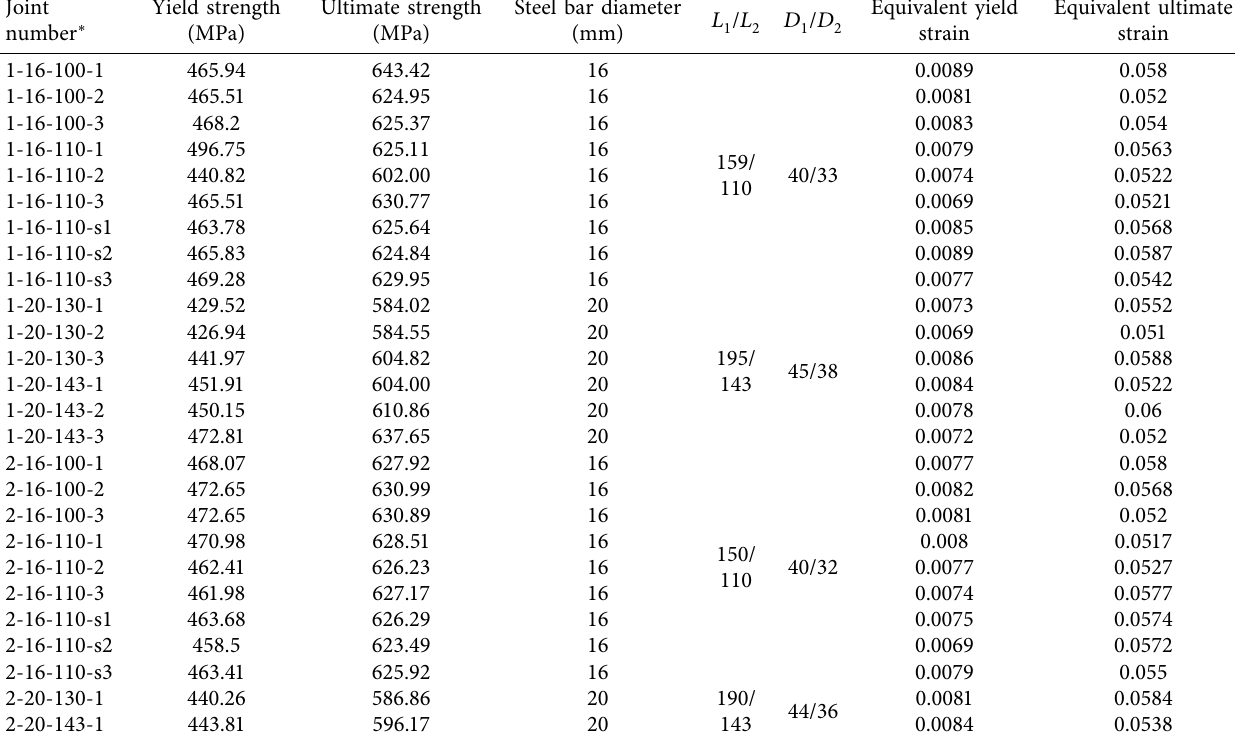
Table 1: The performance parameter processing results of the grouted sleeve.